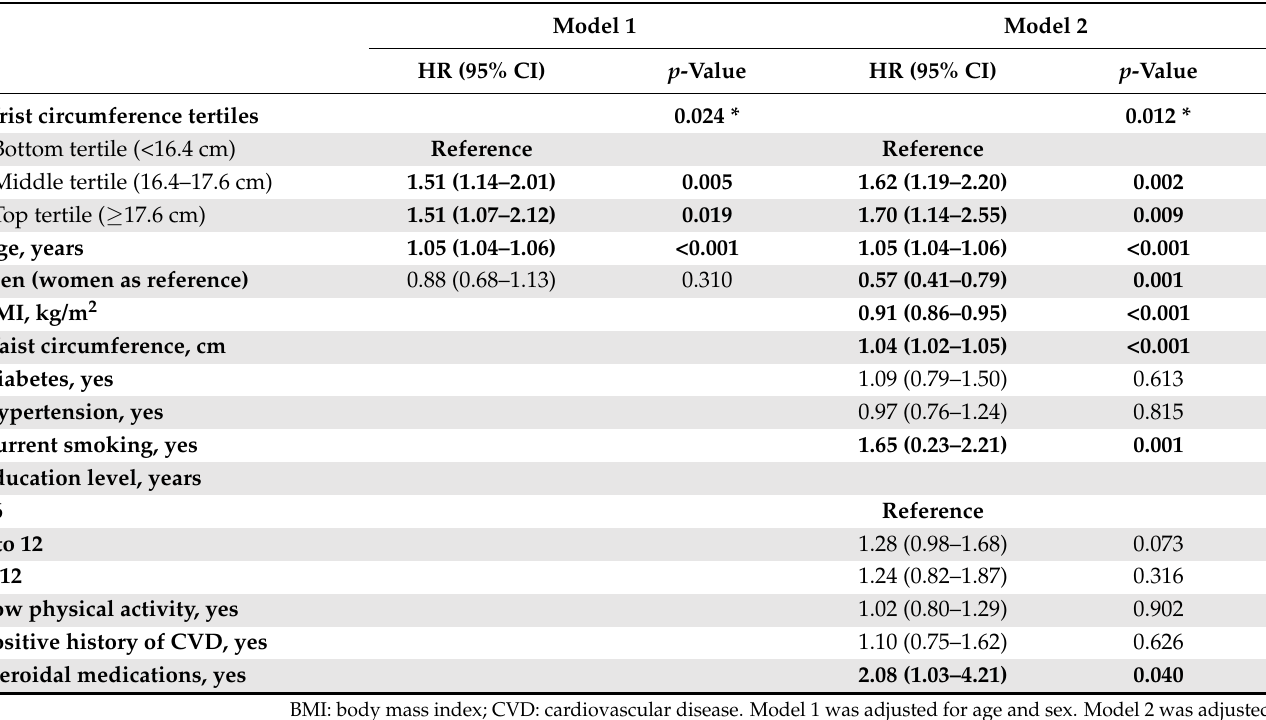
Table 4. Multivariable hazard ratios (HR) and 95% confidence intervals (CI) of incidence of any fracture for wrist circumference as a categorical variable: Tehran Lipid and Glucose Study, 1999–2016.